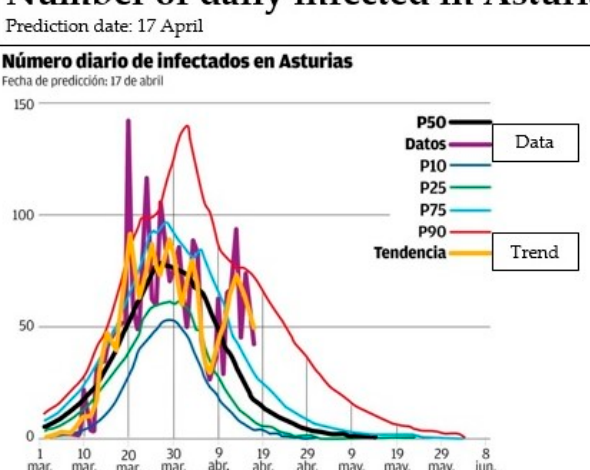
Figure 13. Prediction model for infected cases in the region of Asturias [70].